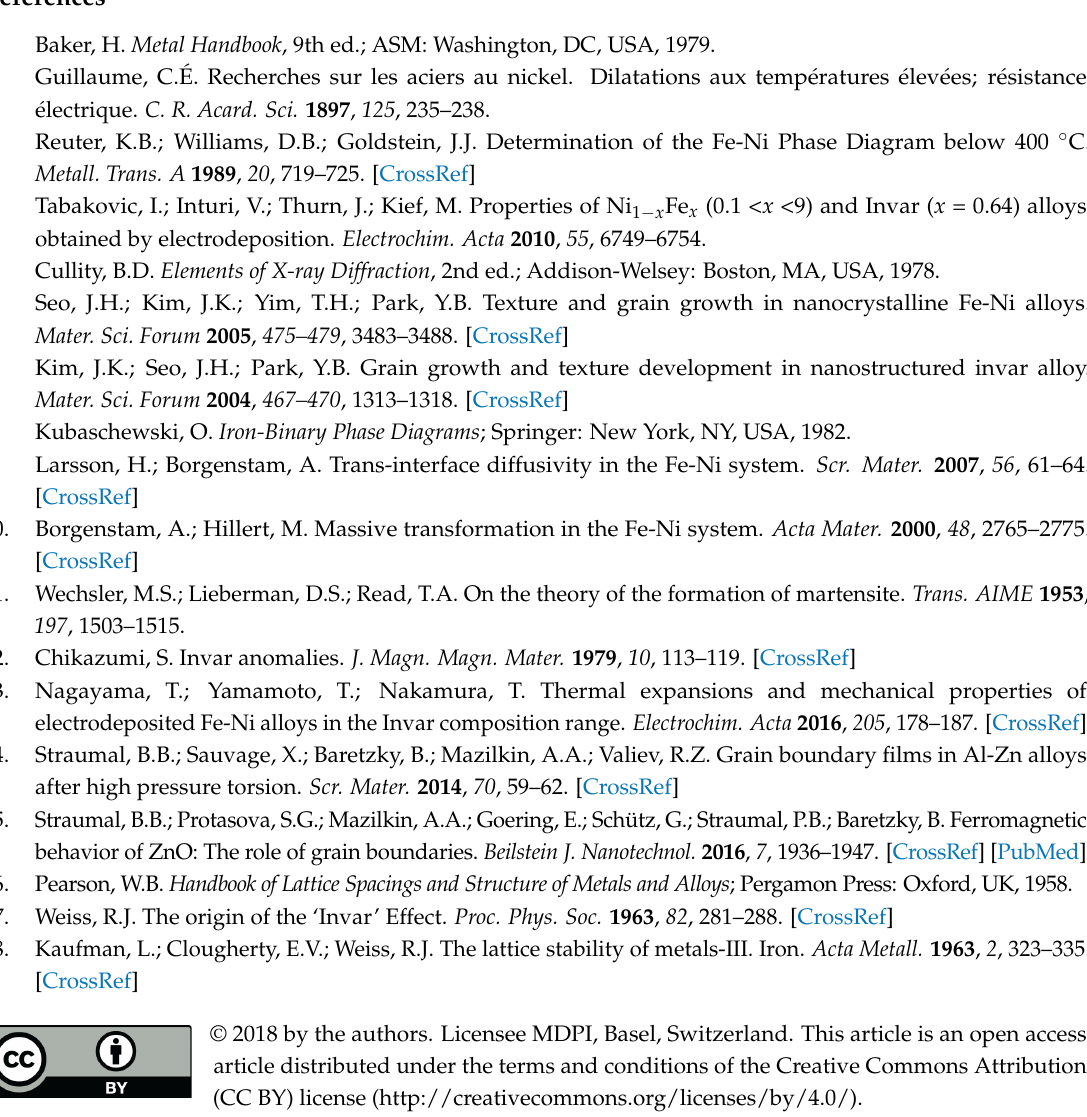
Figure A2. Lattice parameters of the α , γ′ and γ″ phases. The XRD data were collected for the same samples used for Figure 1.